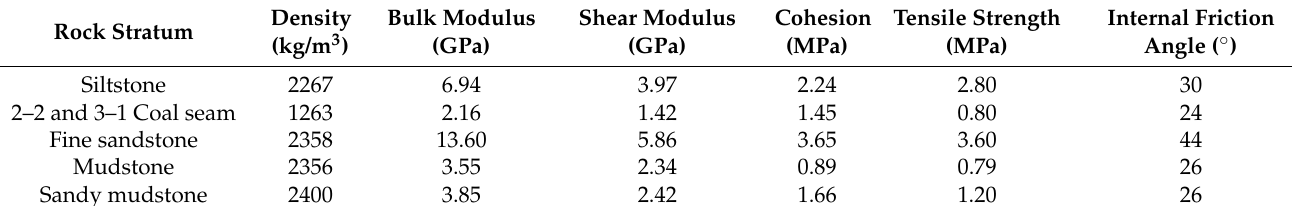
Table 2. Mechanical parameters of model.